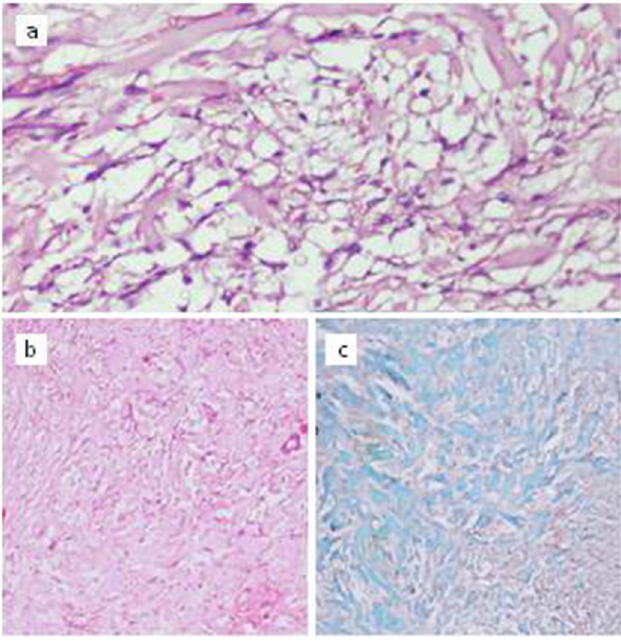
Fig. 3. Photomicrograph showing a) Fascicles of proliferating spindle cells in a hyalinized stroma with extravasated RBC ’ s and cleft-like spaces (H&E-20X), b) Hyalinized stroma (H&E 10X) and c) stroma rich in mucopolysaccharide (Alcian blue stain –